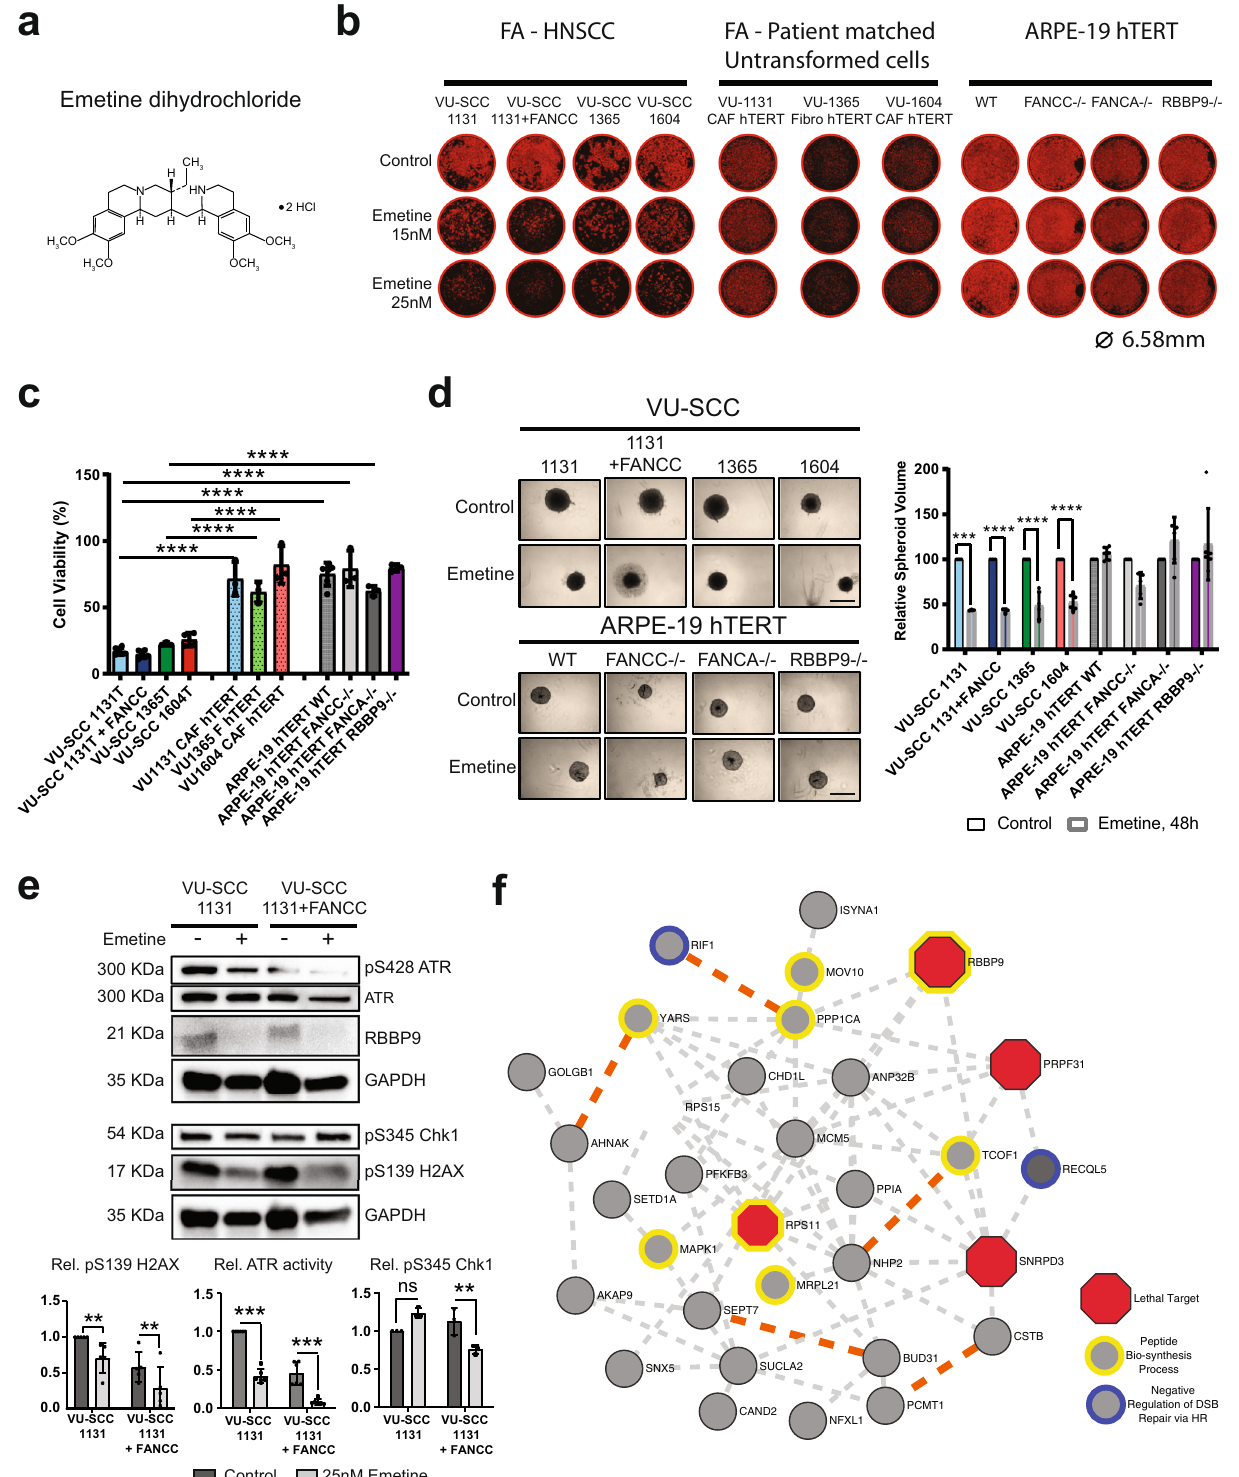
mycoplasma testing and con fi rmed to be negative. See Supplementary Table 1 for a list of cell lines used in this study. Generation of CRISPR knockout cell lines . RBBP9 knockout ARPE-19 hTERT cells were generated by electroporation of a Cas9:tracrRNA:crRNA ribo- nucleoprotein (RNP) complex sequentially. Brie fl y, the RBBP9 crRNA GTGAC- CACCCACGGCTGGTA (200µM) and Alt-R CRISPR-Cas9 tracrRNA (200µM) (IDT, Cat# 1075928) oligos were mixed in equimolar concentrations to a fi